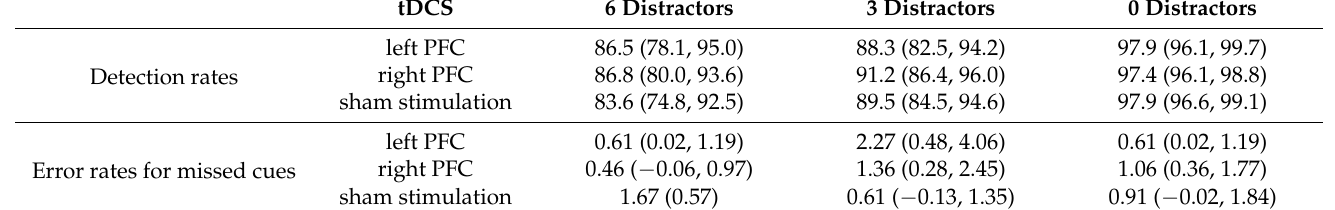
Table 1. Detection rates and error rates for missed cues depending on number of distractors and stimulation conditions (given as percentages, 95% confidence intervals in parentheses). tDCS